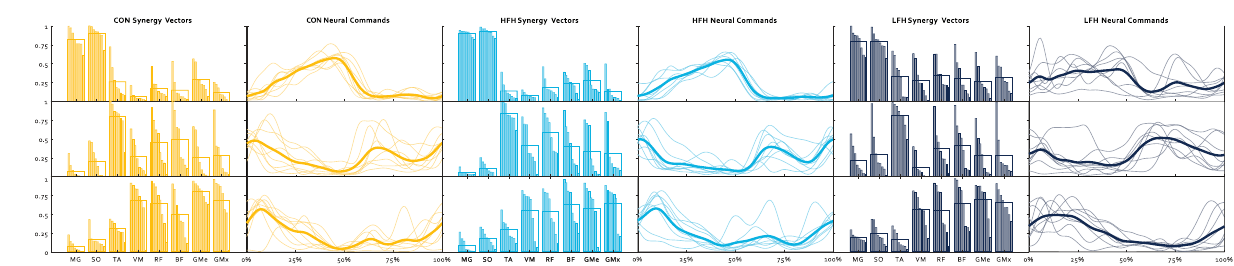
Figure 3. Synergies for CON (gold), HFH (light blue), and LFH (dark blue). The top row corresponds to the Plantarflexion Synergy, the middle row to the Dorsiflexion Synergy, and the bottom row to the Support Synergy. The 1st, 3rd, and 5th columns correspond to Synergy Vectors and the 2nd, 4th, and 6th columns to Neural Commands. Individual participants are represented by thin bars and lines, while thicker bars and lines represent group